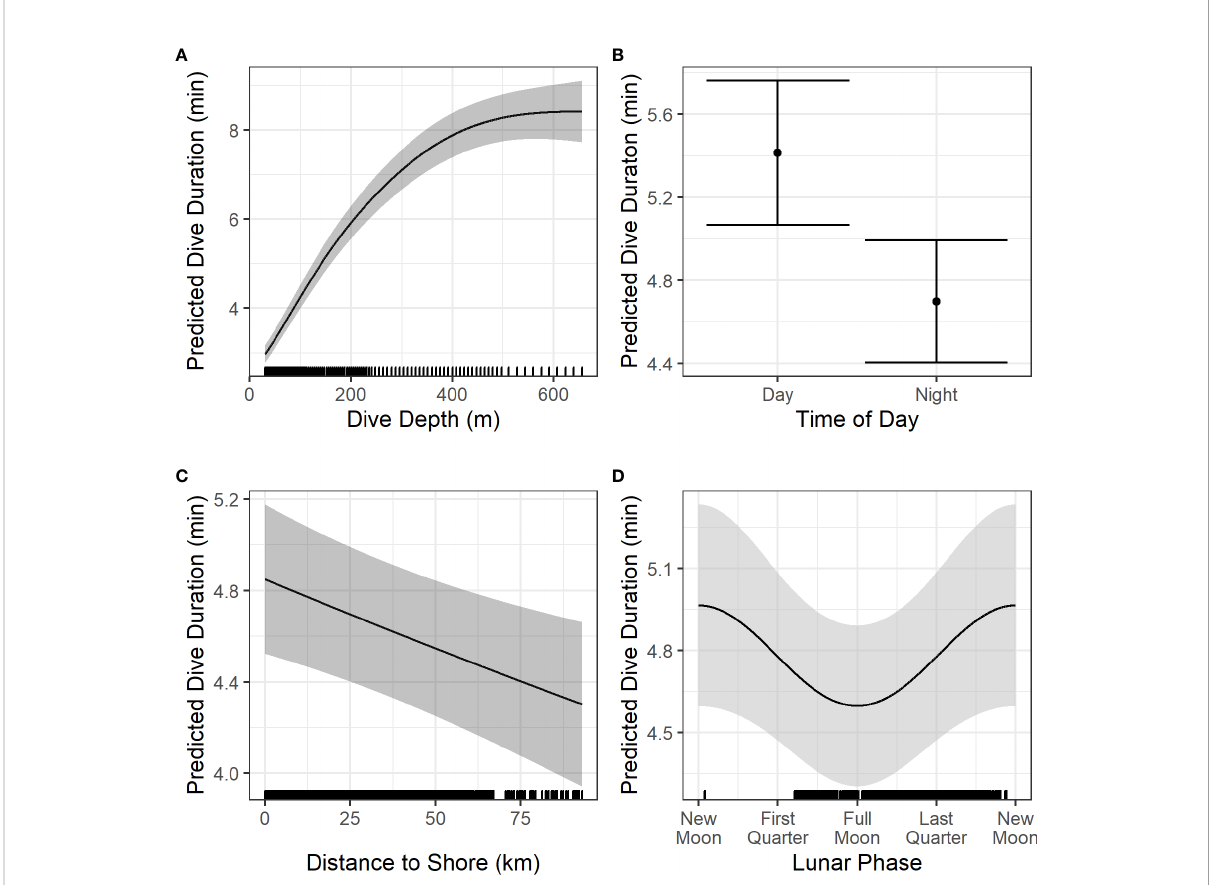
FIGURE 7 Prediction plots of signi fi cant variables (A – D) from the models of dive duration. Solid black lines/dots represent mean predicted values with shaded areas/error bars representing the 95% CI. Hash marks along the x-axis shows the spread of data. For the creation of these plots, values for other predictors in each model were set at the median or modal value as follows: time of day = night, Chl residuals = -0.008, SST = 15.81, distance to shore = 24.68 km, cosine of lunar phase = -0. 435, dive depth = 123.5 m. Chl, Chlorophyll-a (mg m-3); SST, Sea Surface Temperature